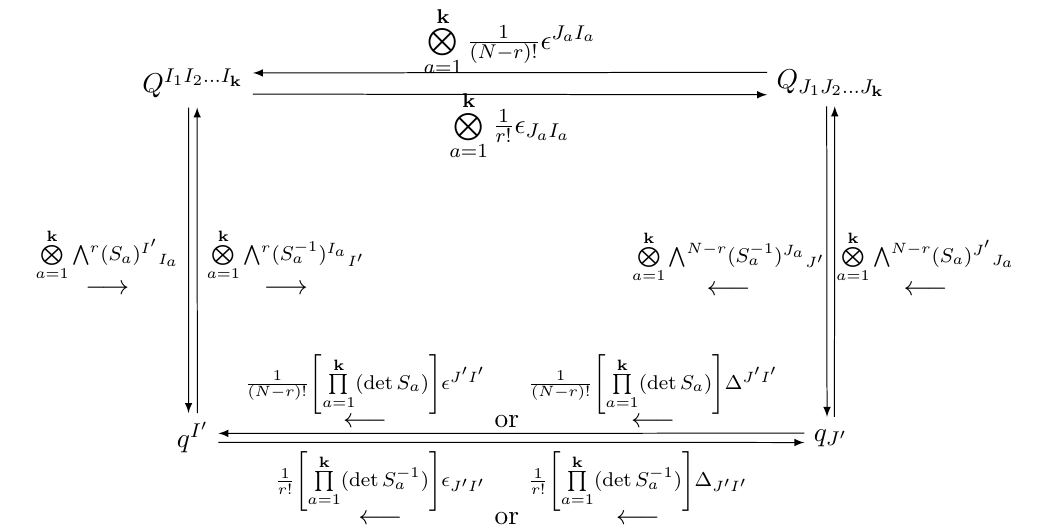
Figure 4 . Commutative diagram relating the k -fold rank r antisymmetric tensor operators and rank N r antisymmetric tensor operators in the standard basis and the \basis of eigenvectors" of (cid:0) the moment map. I a ; I 0 should be understood as multi-indices of size r and J a ; J 0 as multi-indices of size N r . The arrow under N V n S a , N V n S (cid:0) 1 and the determinants indicate which side to a (cid:0) act on. For the bottom arrows, (cid:15) is used for odd k and (cid:1) is used for even k